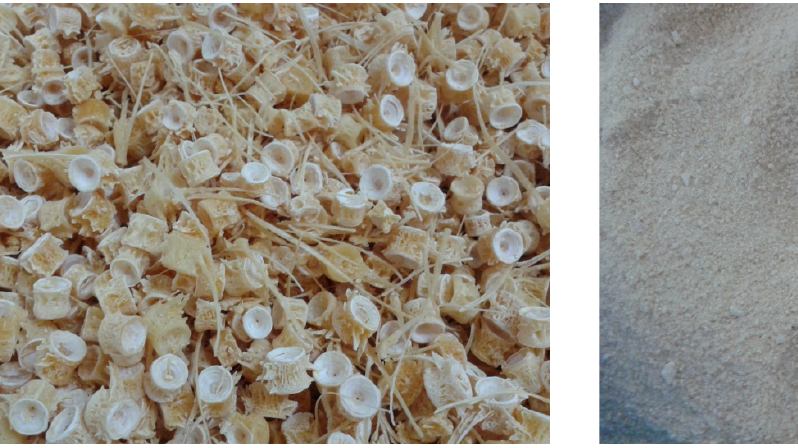
Figure 7: Final product ASP- calcium preparation from salmon.